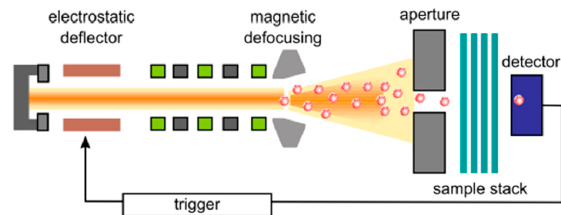
Figure 12. Schematic representation of a single-ion irradiation setup, adapted from reference [244]. [A color figure can be viewed in the online issue, which is available at wileyonlinelibrary.com.]. Poly (vinylidene fluoride) (PVDF) is one of the most attractive polymers commercially